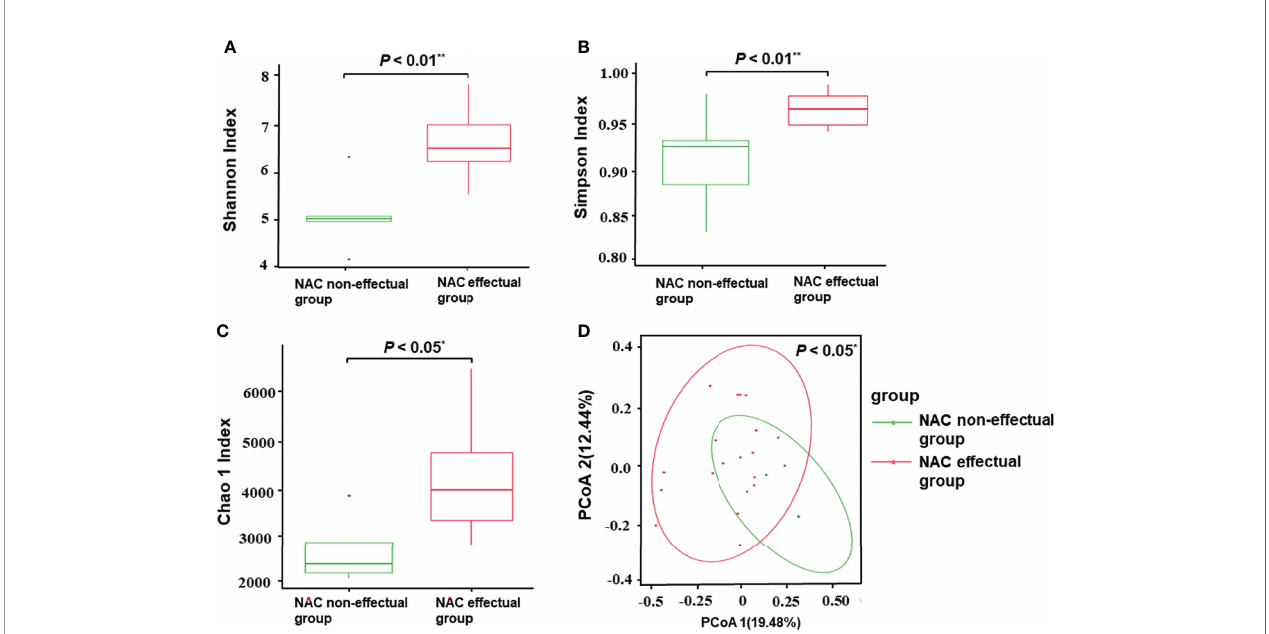
FIGURE 2 | Comparisons of alpha-diversity and beta-diversity between the NAC effectual group (n = 5) and the NAC non-effectual group (n = 18). (A – C) Alpha- diversity of the two groups at the species level, measured in terms of the Shannon (A) , Simpson (B) , and Chao1 index (C) . (D) PCoA of unweighted UniFrac analysis showed that the overall fecal microbiota composition was different between the NAC non-effectual group and the NAC effectual group. NAC, neoadjuvant chemotherapy; PCoA, principal coordinate analysis. Superscript symbols indicate statistically signi fi cant differences between the two groups: * p < 0.05, ** p <